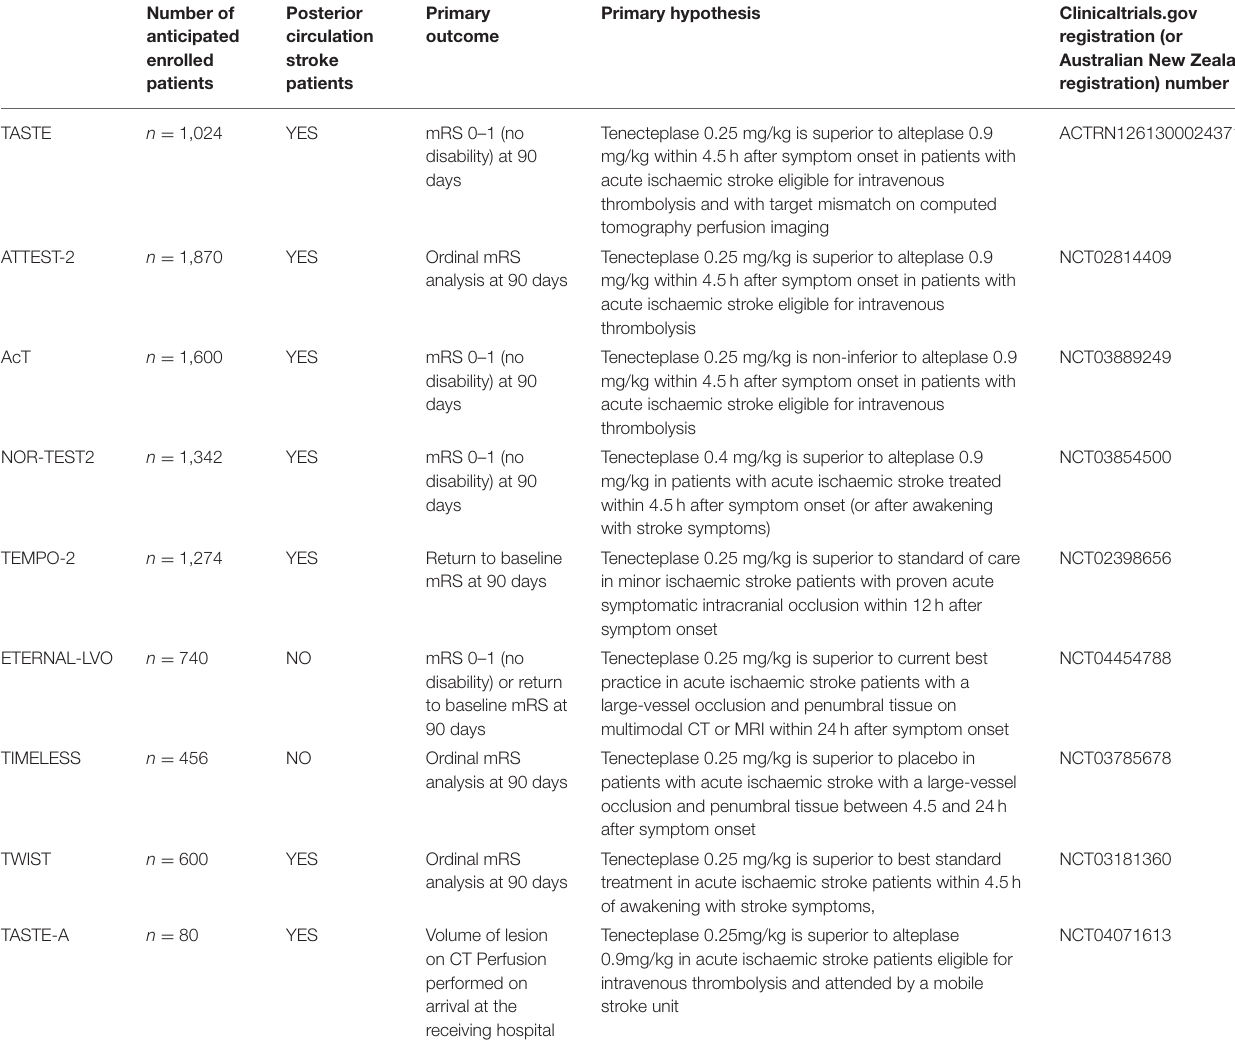
TABLE 1 | Ongoing tenecteplase randomized controlled